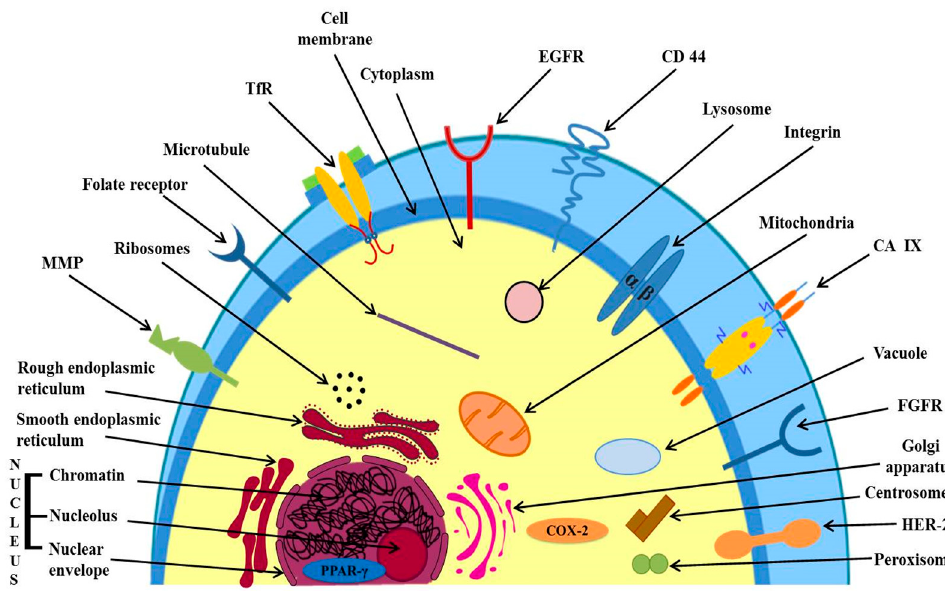
Figure 2. Targets (extracellular and intracellular receptors or over-expressed proteins) for active drug targeting in cancer therapy. Targets may also be organelles, e.g., lysosomes and mitochondria. Targeting of Epidermal Growth Factor Receptor